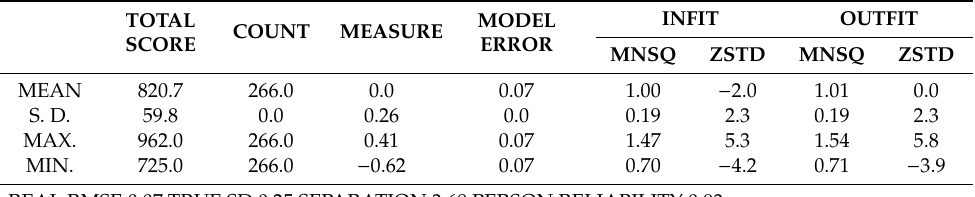
Table 5. Item reliability of taekwondo electronic protector cognition scale (Measured ITEM).